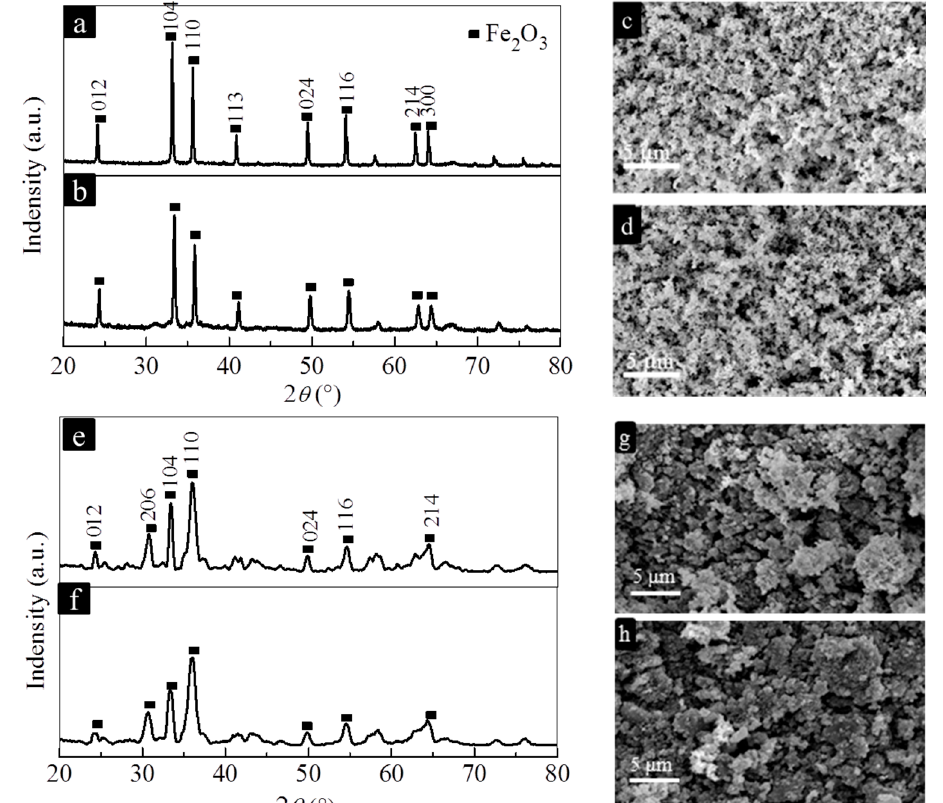
Figure 7. XRD spectrum and SEM pictures of the fresh and the regenerated Fe 2 O 3 (104)/Al 2 O 3 and Fe 2 O 3 /Al 2 O 3 . ( a , b ) XRD spectrum of the fresh and regenerated Fe 2 O 3 (104)/Al 2 O 3 ; ( c , d ) SEM pictures of the fresh and regenerated Fe 2 O 3 (104)/Al 2 O 3 ; ( e , f ) XRD spectrum of the fresh and regenerated Fe 2 O 3 /Al 2 O 3 ; ( g , h ) SEM pictures of the fresh and regenerated Fe 2 O 3 /Al 2 O 3 .